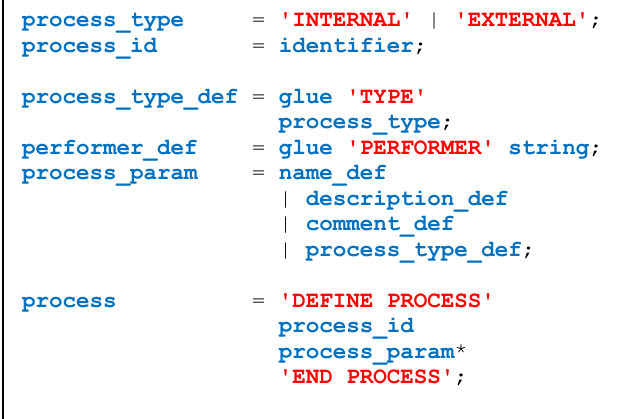
Fig. 4. Process definition in the proposed DSL language.